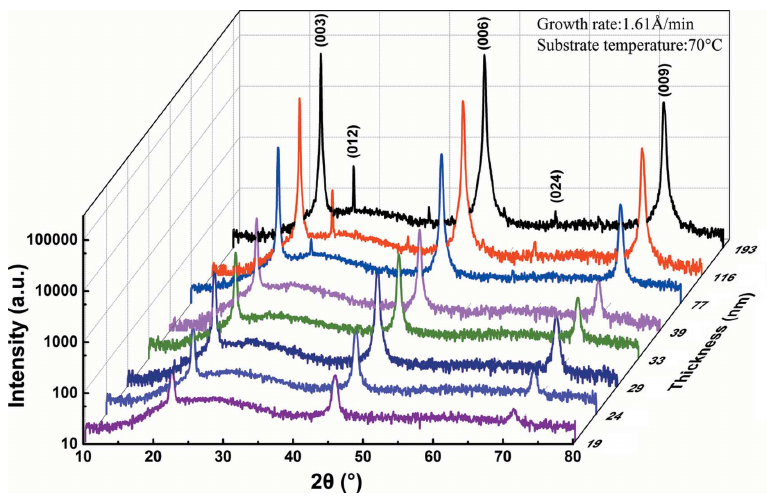
Figure 6 XRD patterns of Bi thin films with various thicknesses. The thicknesses are 19, 24, 29, 33, 39, 77, 116 and 193 nm (the growth rate is 1.61 A˚ min (cid:5) 1 , the substrate temperature is 70 (cid:2) C and T s / T m = 0.63).